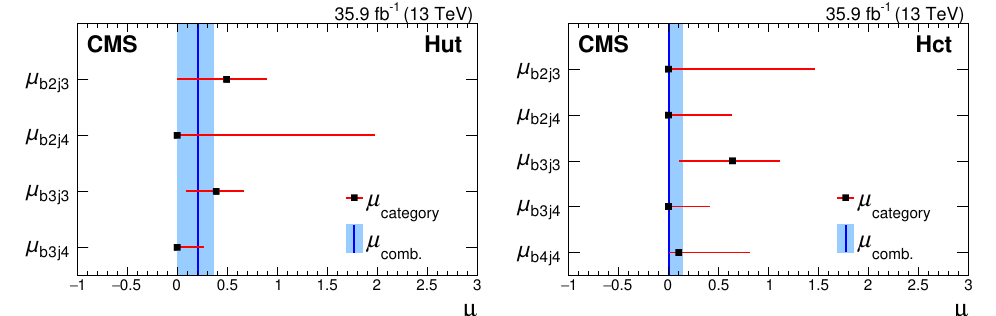
Figure 8 . The best (cid:12)t signal strength ( (cid:22) ) for Hut (left) and Hct (right), which is restricted to positive values in the